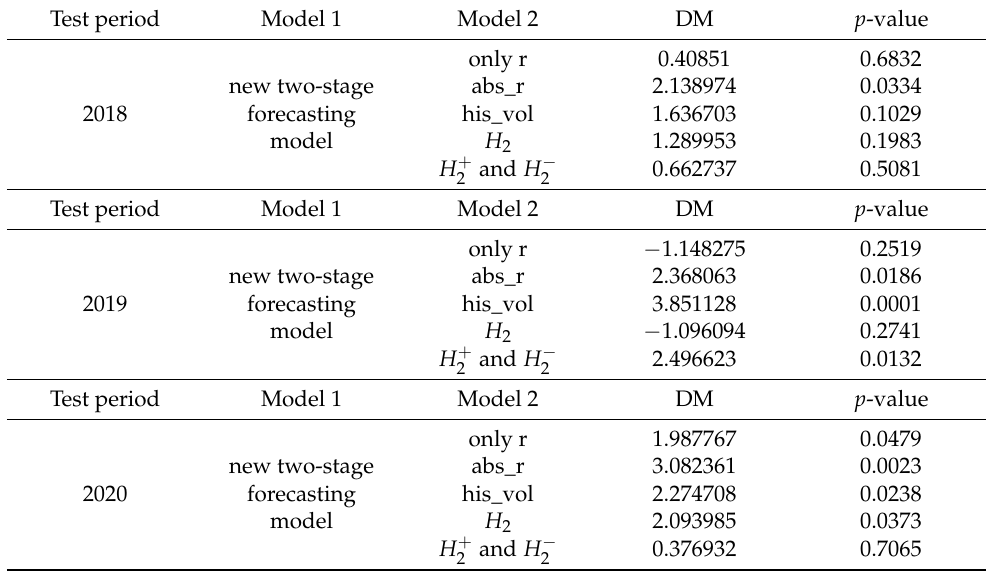
Table 7. Diebold–Mariano test of new two-stage forecasting